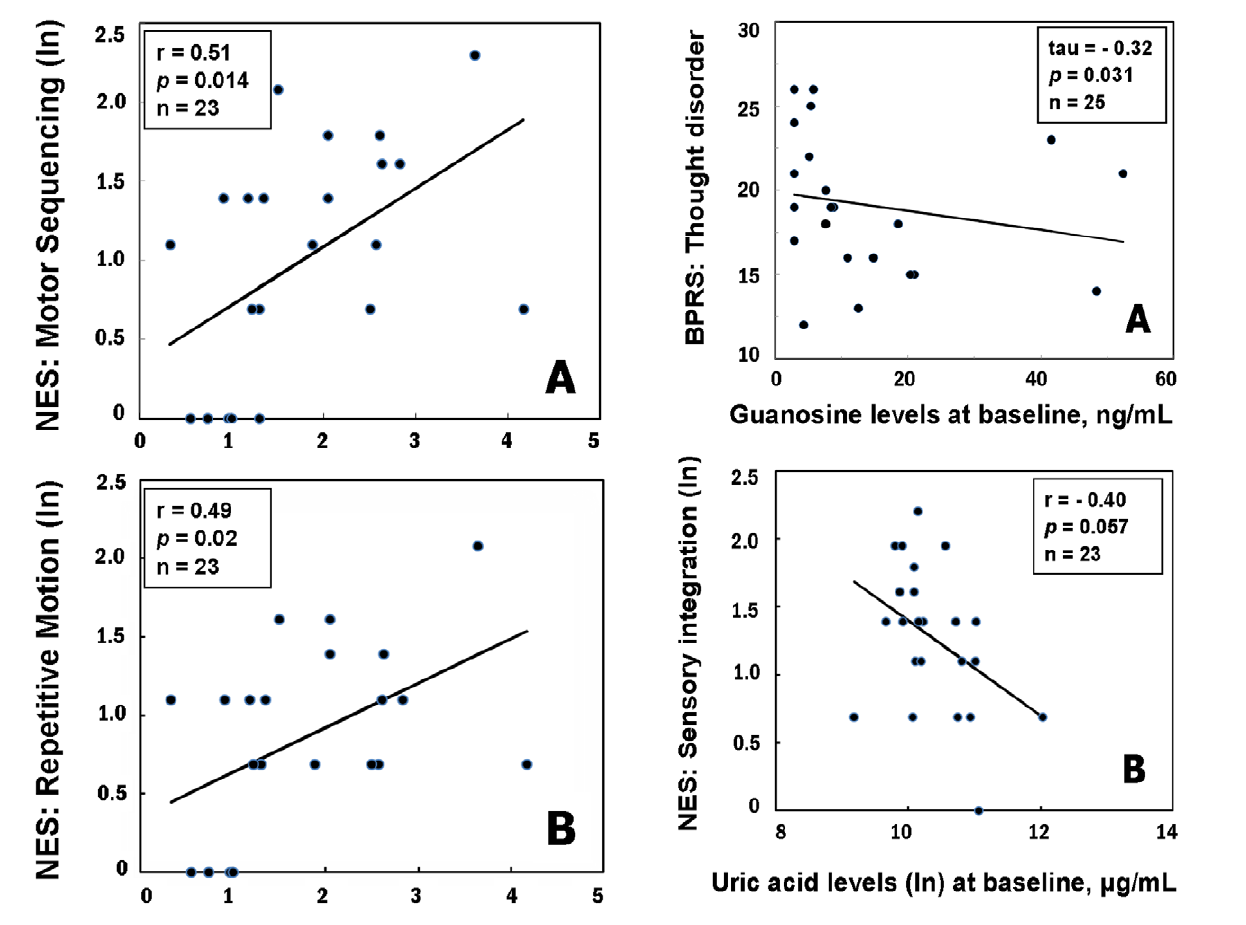
Figure 2. Pearson correlations between Neurological Evalua- tion Scale (NES) and ratio of xanthosine to granosine in first- episode neuroleptic-naı¨ve patients with schizophrenia (FENN- SZ) at baseline. A, Motor sequencing; B, Repetitive motion. All data were transformed to natural logarithm (ln). The NES data were available at baseline from 23 FENN-SZ.